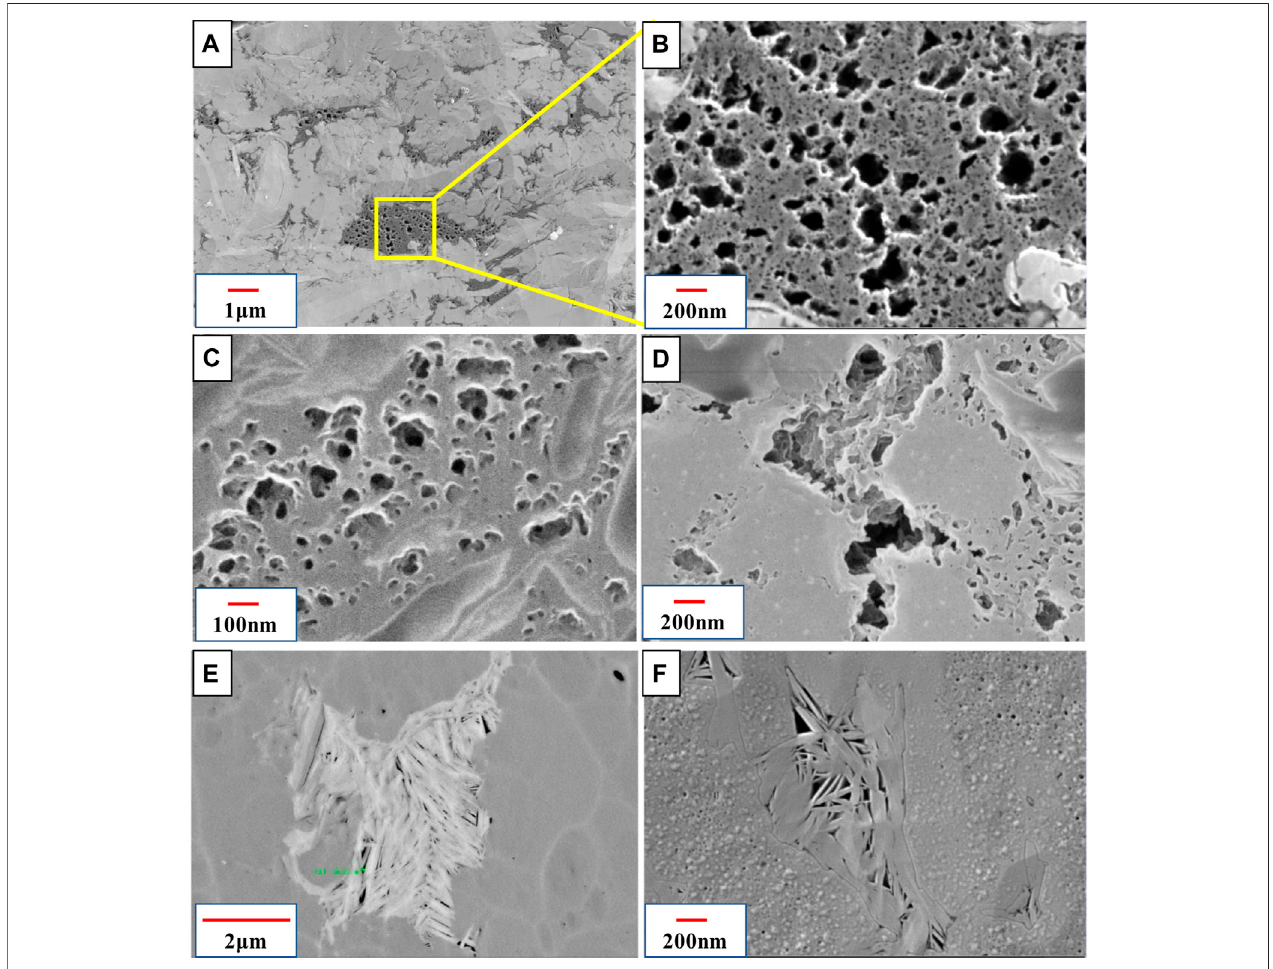
FIGURE 4 | FIB-SEM images (A,B,E,F) , FIB-HIM images (C,D) . (A,B) : 4,085.46 m, XNY-1 Well, Member I of the Longmaxi Formation; (C) 4,087.84 m, XNY-1 Well, Member I of Longmaxi Formation; (D) 4,089.63 m, XNY-1 Well, Member I of Longmaxi Formation; (E) 4,062.35 m, XNY-1 Well, Member I of Longmaxi Formation; (F) 4,072.92 m, XNY-1 Well, Member I of Longmaxi